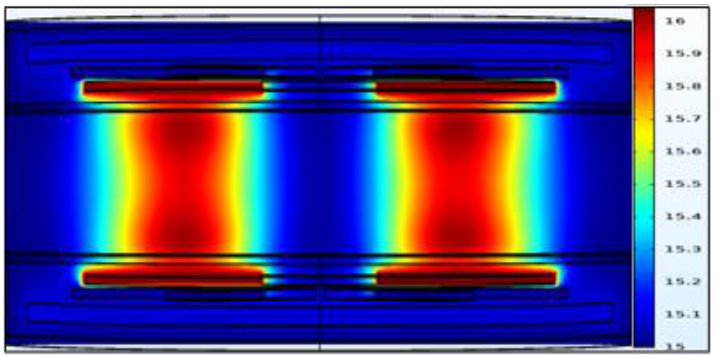
Figure 11. Thermal field distribution between coupled coils (1).